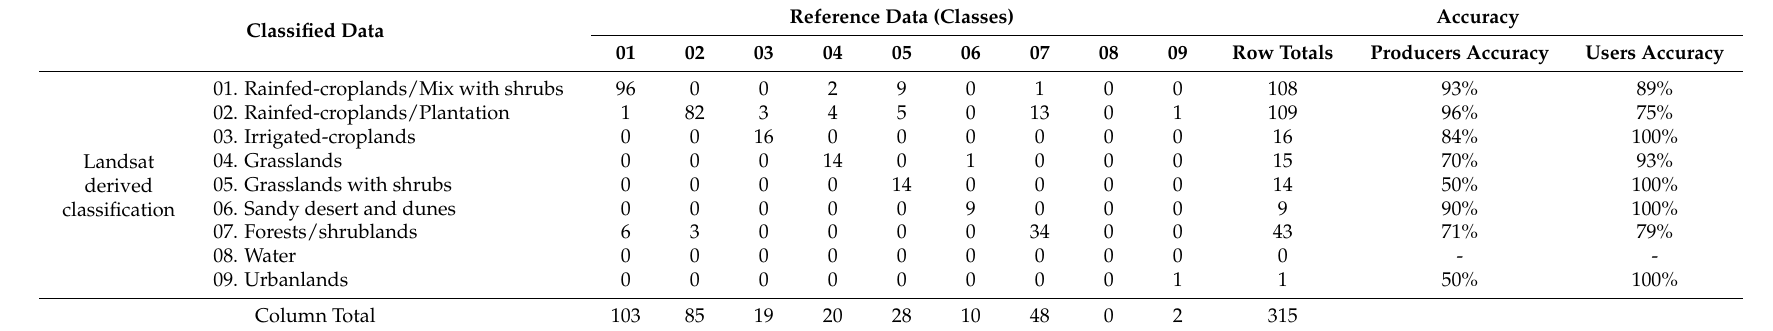
Table 5. Accuracy assessment of land use/land cover map using field-plot data using error matrix method.